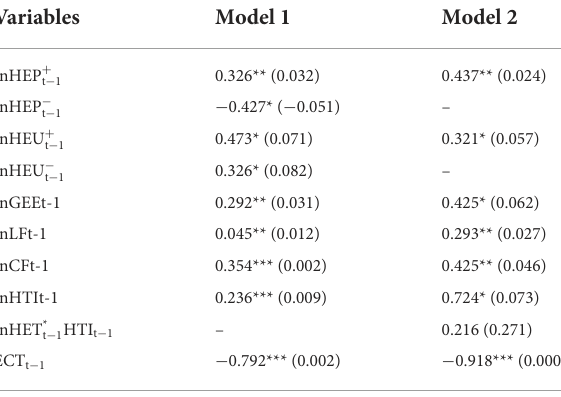
TABLE 6 Asymmetric effects of short-run elasticity of variables in NARDL